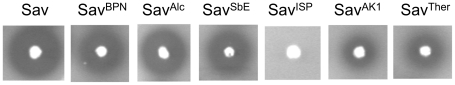
Activity of rationally constructed Sav-hybrid variants.The donor fragments at each of the 6 regions derives from one of the subtilisins, which is indicated in superscript in the figure. An active variant is indicated by the production of a clearing zone or halo around the B. subtilis colony due to digestion of casein embedded in the agar growth medium.